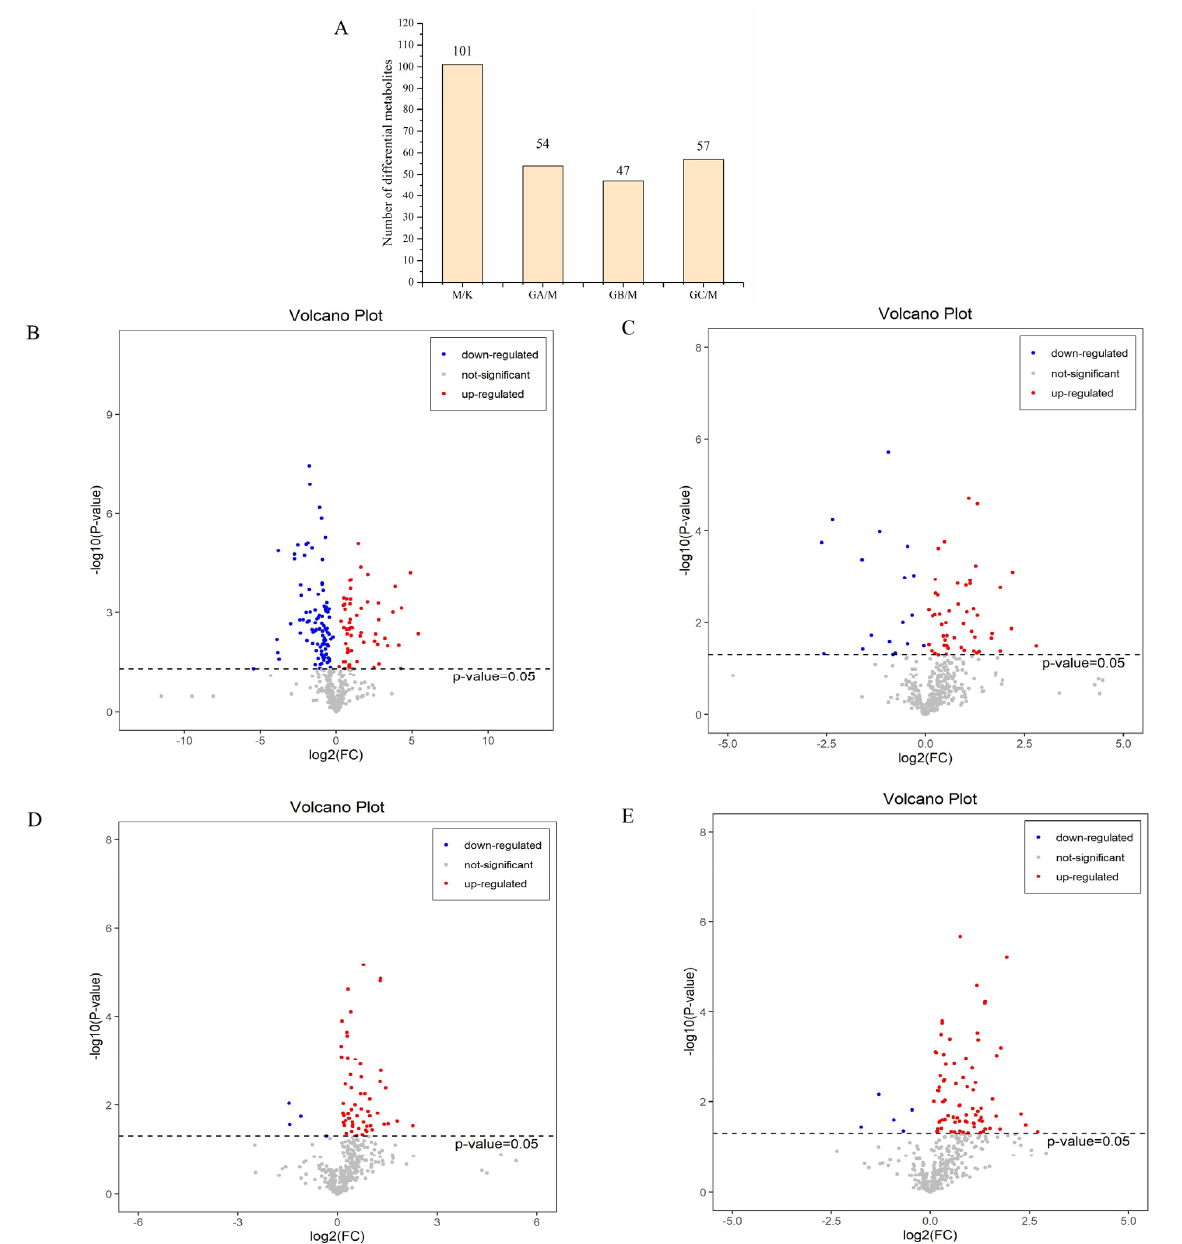
Figure 3. Screening of differential metabolites in the intestine of rats with a high-fat diet after treatment with LYCRPLs: ( A ) statistics showing the numbers of differential metabolites among groups; ( B ) volcano map of differential metabolites between group K and group M; ( C ) volcano map of differential metabolites between group GA and group M; ( D ) volcano map of differential metabolites between group GB and group M; ( E ) volcano map of differential metabolites between group GC and group M; ( B – E ) the red dots represent the significantly up-regulated differential metabolites, the blue dots represent the significantly down-regulated differential metabolites, and the gray dots represent the insignificant differential metabolites. Note: the results of the T test, p < 0.05 means significant.